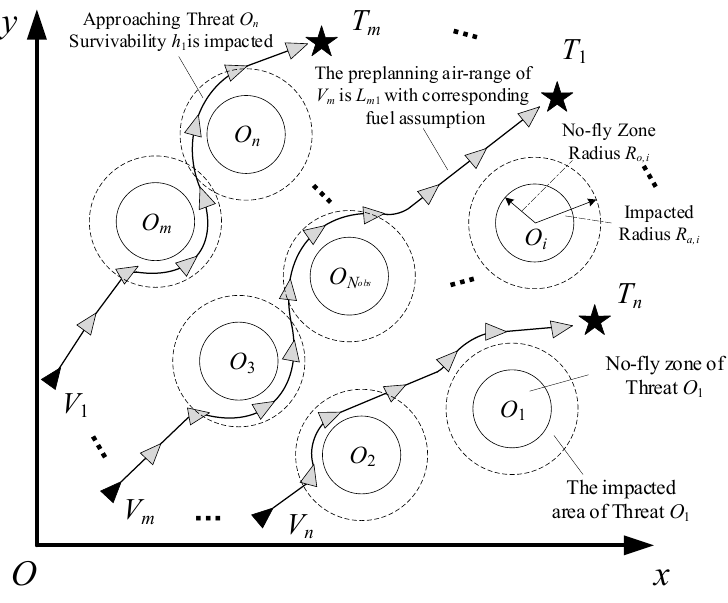
Figure 6. The coupling of the UAV mission assignment and path planning.